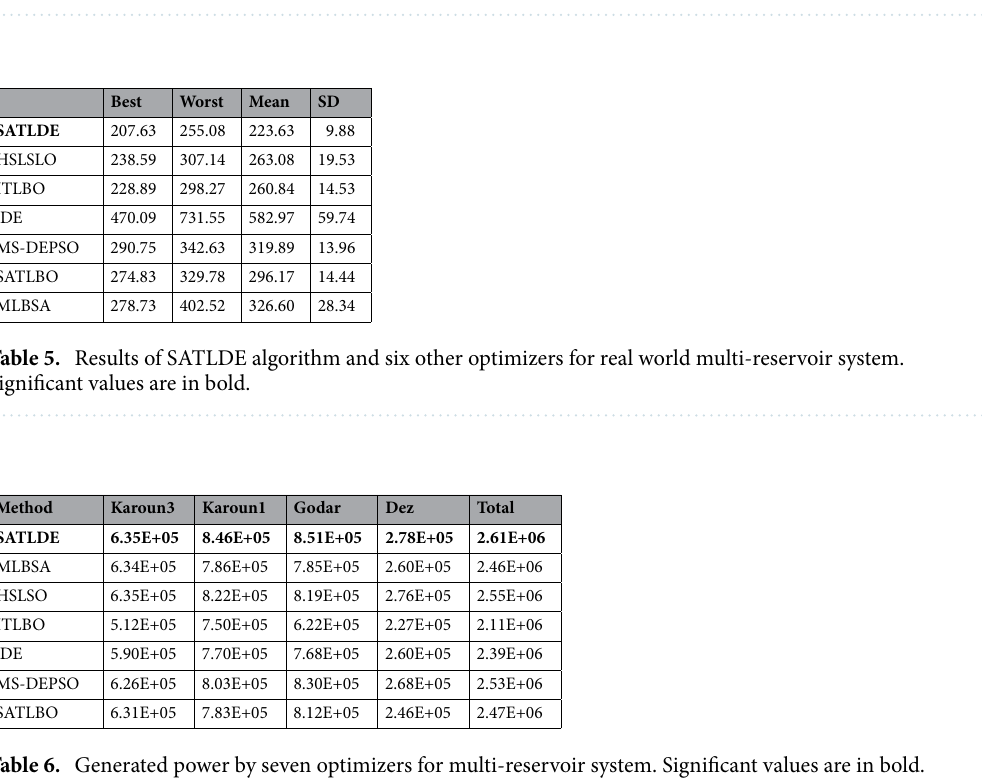
Table 6. Generated power by seven optimizers for multi-reservoir system. Significant values are in bold.